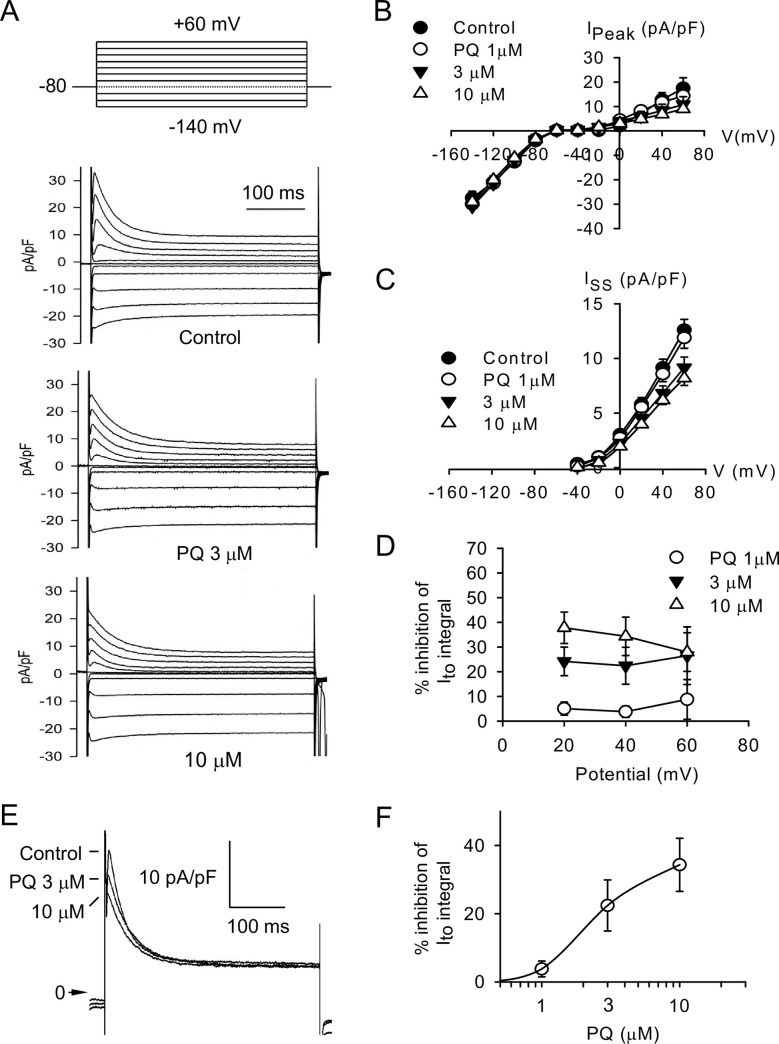
Effect of PQ on K+ currents.(A) Families of current traces elicited by a series of 400-ms long depolarizing or hyperpolarizing pulses from a holding potential of −80 mV in the absence and presence of 3 and 10 μM PQ. (B, C) Averaged I–V relationship for Ito and IK1 peak currents (B) and Iss (C) observed in the absence, and presence of 1, 3, and 10 μM PQ. Peak Ito current was measured as the difference between the peak current and the steady-state current at the end of the pulse. Iss current was measured as the steady-state current at the end of the pulse. Each data point indicates mean ± SD from 5 myocytes. (D) Percent inhibition of the Ito integral by 1, 3, and 10 μM PQ calculated at different depolarizing potentials. Data points are mean ± SD (n = 5). (E) Original superimposed families of current traces generated by 400-ms depolarizing pulses to +40 mV from a holding potential of −80 mV in the absence or presence of increasing PQ concentrations. The arrow indicates the zero current density level. (F) Concentration–response curve for the effect of PQ on the integral of Ito at +40 mV. Data points are mean ± SD (n = 5). The continuous line was drawn according to the fitting of the Hill equation.